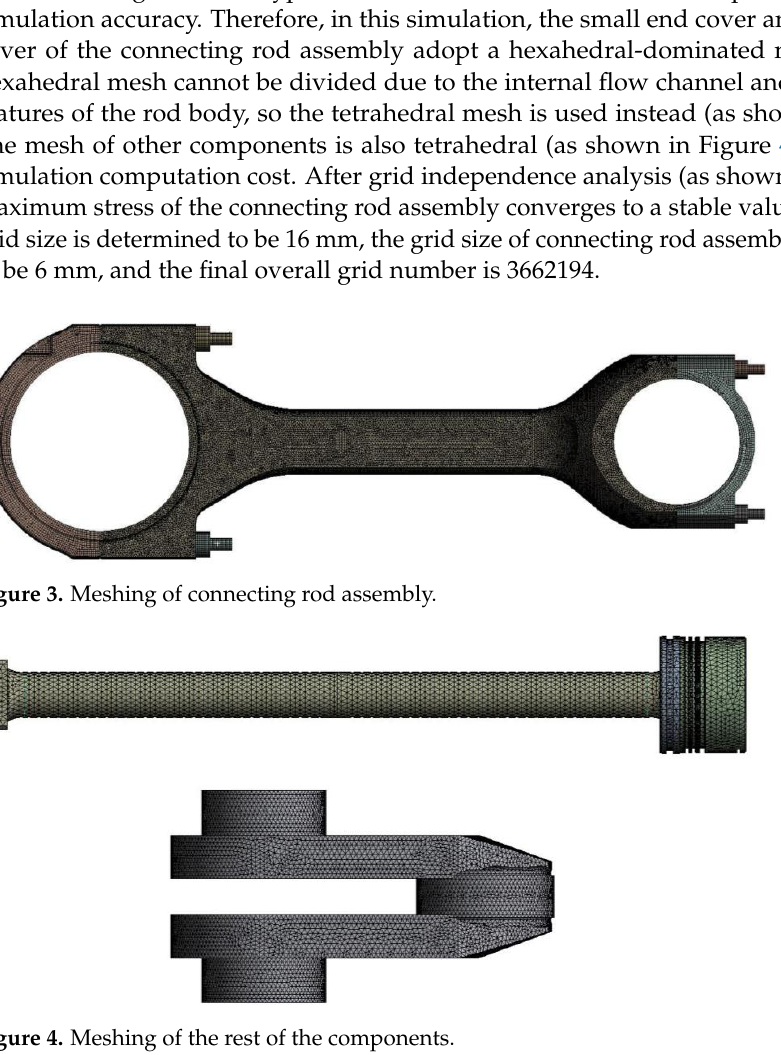
Figure 4. Meshing of the rest of the components. Table 2. Grid independence analysis in simulation calculation of connecting rod assembly.